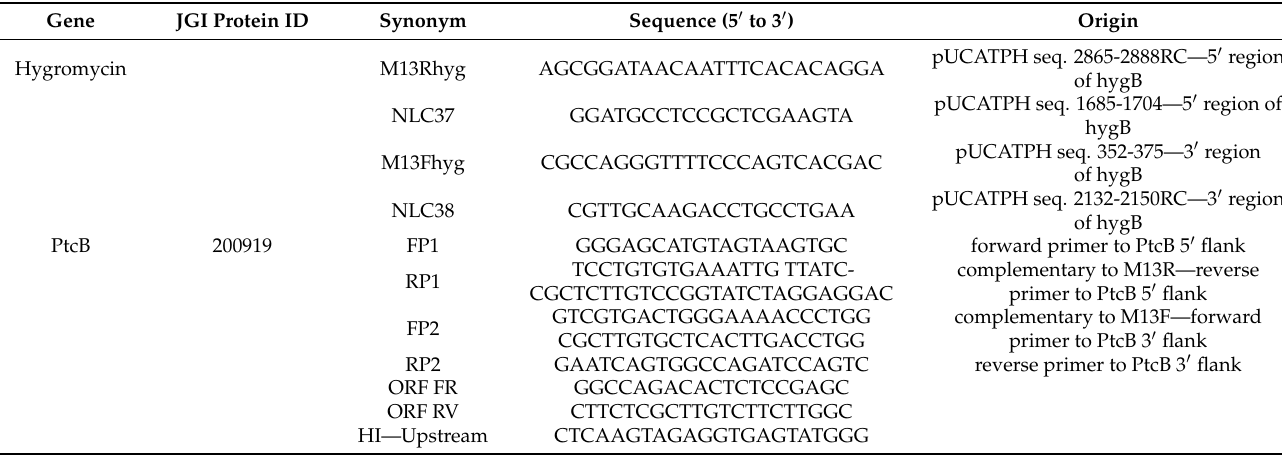
Table 1. Primer sequences for the construction of C. heterostrophus transformation vectors and the verification of mutants. Hph, hygromycin resistance cassette, see